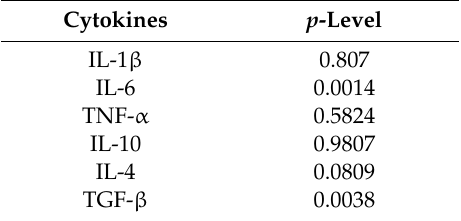
Table 4. Two-way ANOVA uncorrected Fisher’s Least Significant Di ff erence (LSD) test in mRNAs for pro-inflammatory cytokines (IL-1 β , IL-6, TNF - α ), and for anti-inflammatory cytokines (IL-4, IL-10 and TGF- β